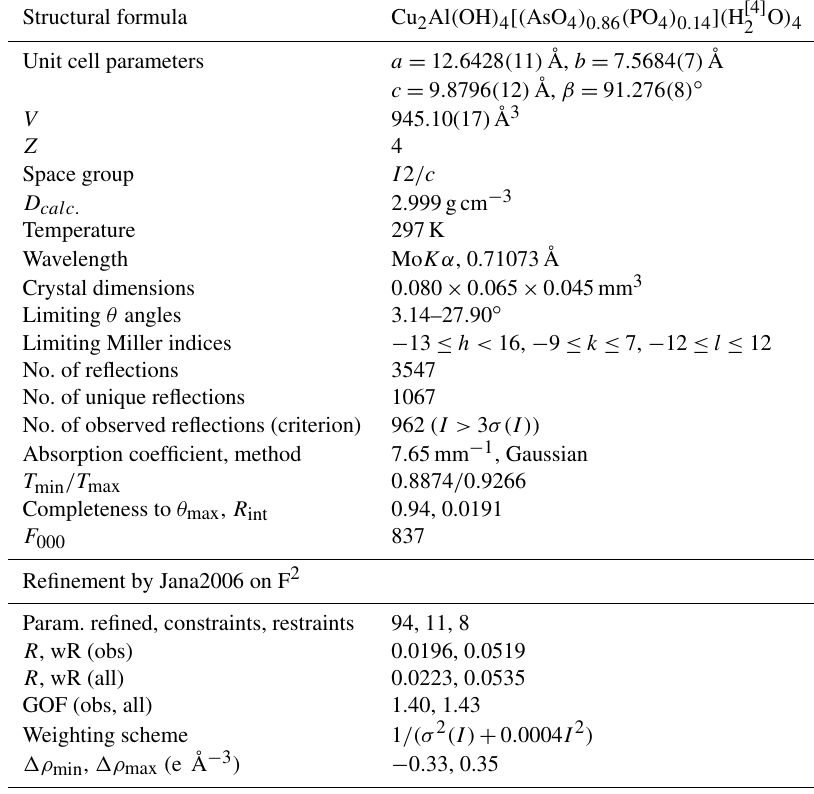
Table 2. Crystal data, collection and refinement parameters for liroconite. Structural